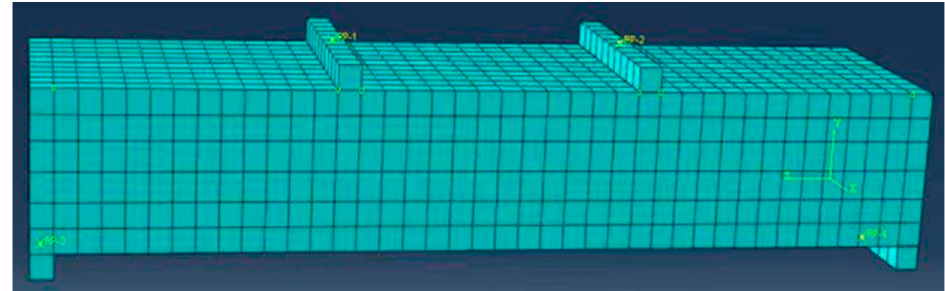
Figure 15. Finite element model of the prestressed hollow slab.